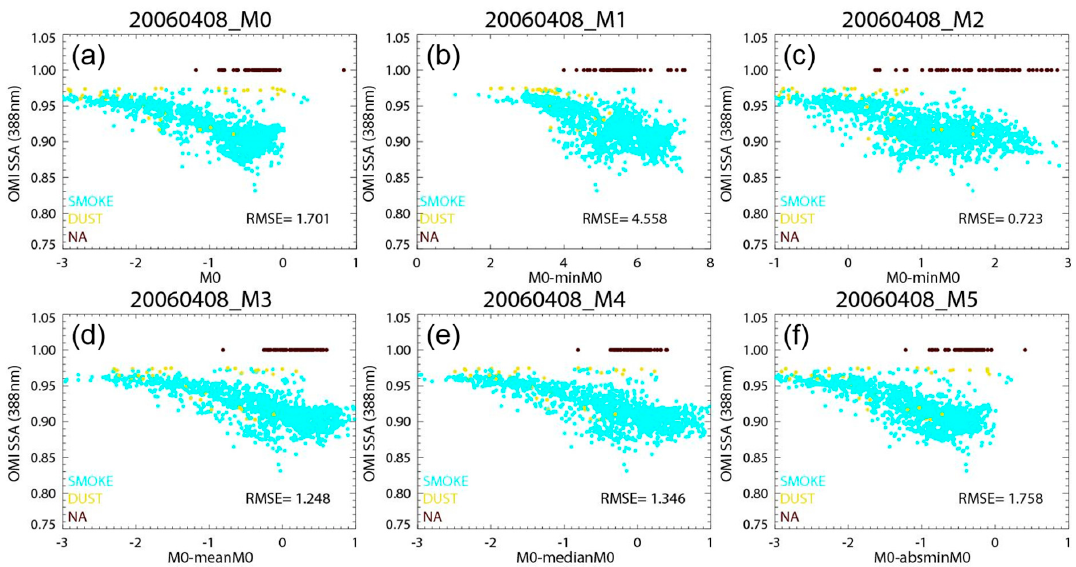
Figure 5. Scatter plot of SAIs (388 nm) versus OMI lv.2 SSA for 8 April 2006. The empirical model of SAIs from ( a ) to ( f ) is the same as that listed in Table 4. These scatterplots use an AOD criterion of greater than 0.5 and a UVAI criterion of greater than 0.5 pixels. Among the five empirical SAI models, the M2 ( c ) has the smallest RMSE value.